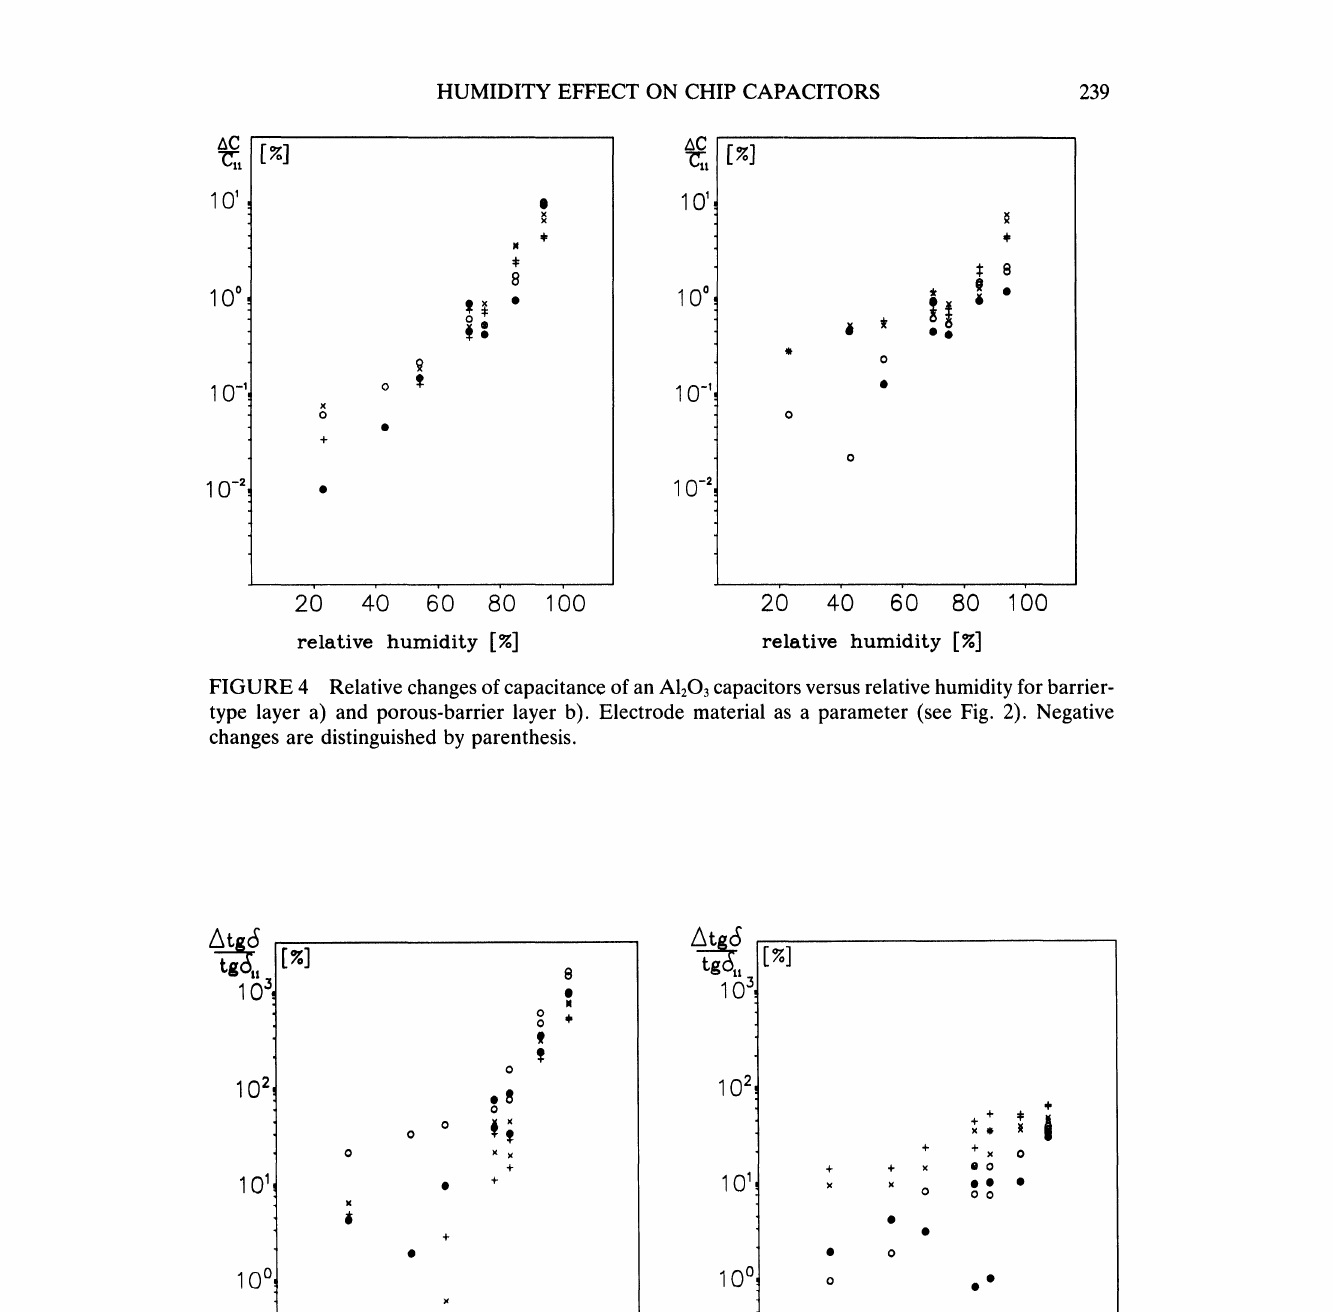
FIGURE 5 Relative changes of loss tangent of an A1203 capacitors versus relative humidity for barrier- type layer a) and porous-barrier layer b). Electrode material as a parameter (see Fig. 2). Negative changes are distinguished by